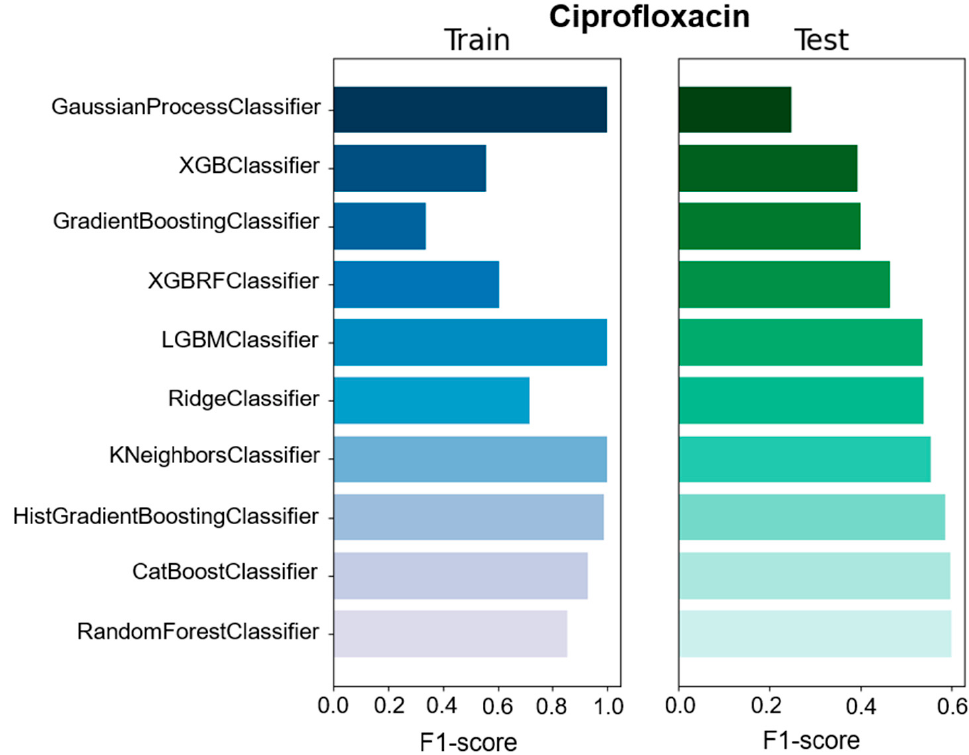
Figure 1. The comparison of F1-score of ten classification models used for gene expression prediction for ciprofloxacin. The blue color represents the training dataset and the green color represents the test dataset.